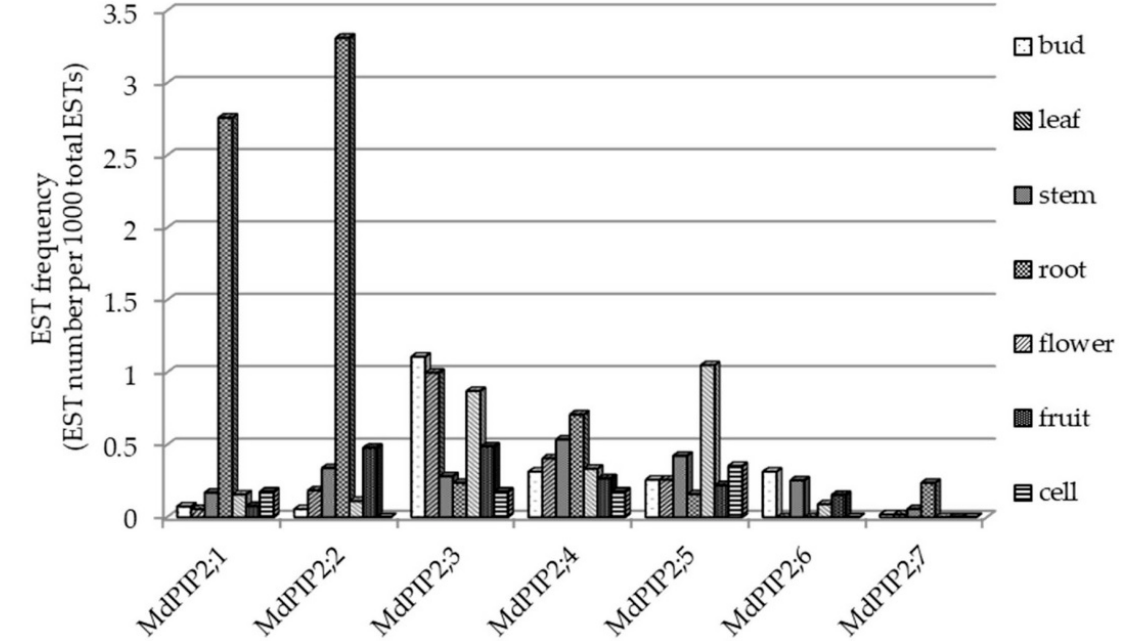
Figure 4. The frequency of the various MdPIP2 ESTs present in cDNA libraries constructed from RNA extracted from buds, leaves, stems, roots, flowers, fruit and in vitro cultured cells.